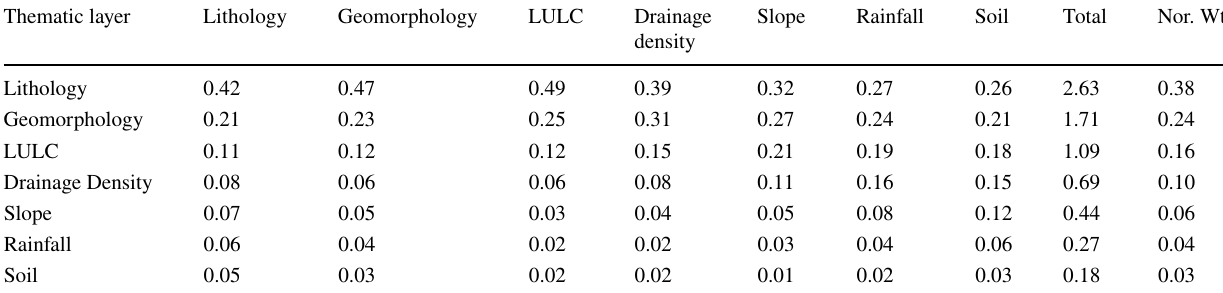
Table 2 Normalized pair-wise matrix